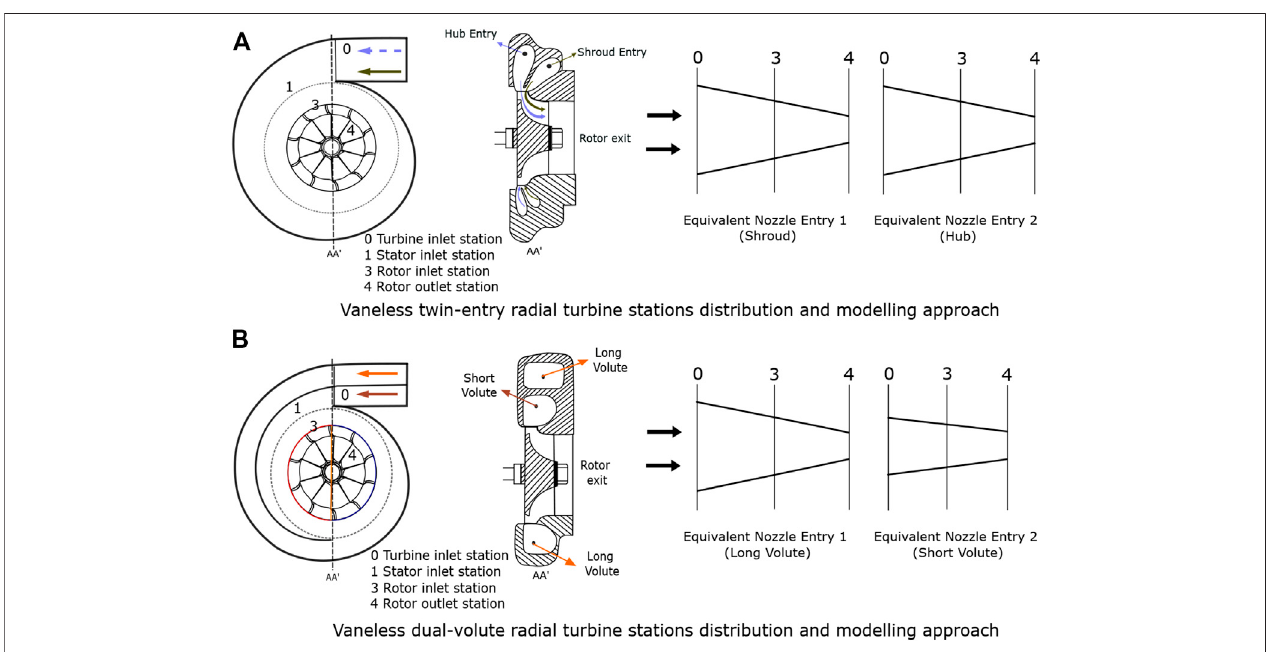
FIGURE 22 | Vaneless double-entry turbines station distribution and two entries into two equivalent nozzles, Serrano et al. (2020b).